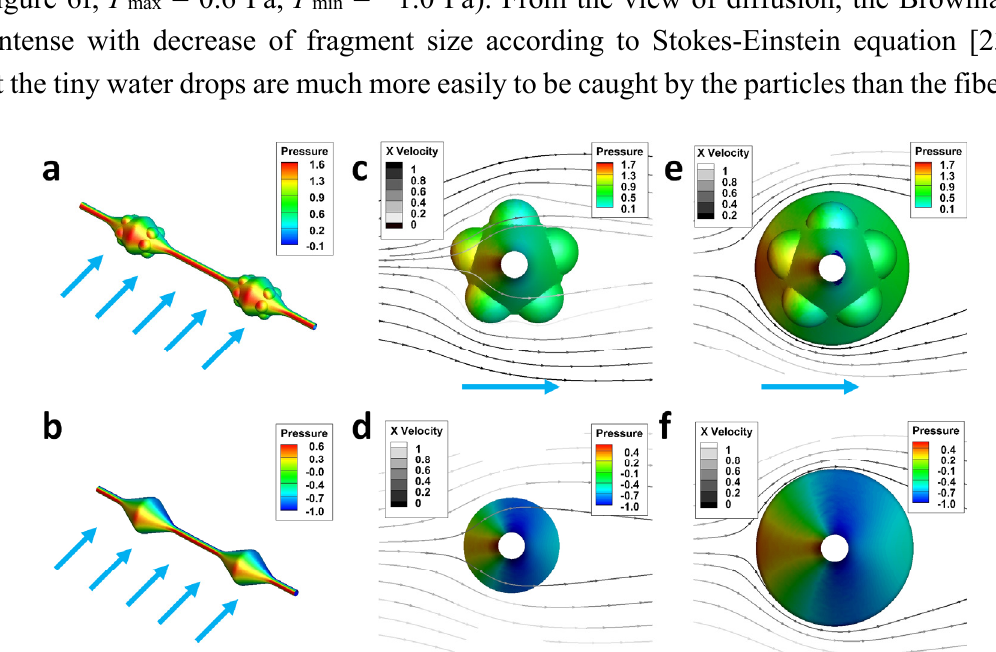
Figure 6. Computational fluid dynamics (CFD) simulation nephograms of bead-on-string fiber with humped and smooth surface. Perspective view of the bead-on-string fibers with humped ( a ) and smooth surface ( b ); Comparison of the side view of the fibers in the humped position ( c ) and the same position on the smooth fiber ( d ); Comparison of the distribution of streamlines at the beads with maximum diameter on the humped ( e ) and smooth ( f )